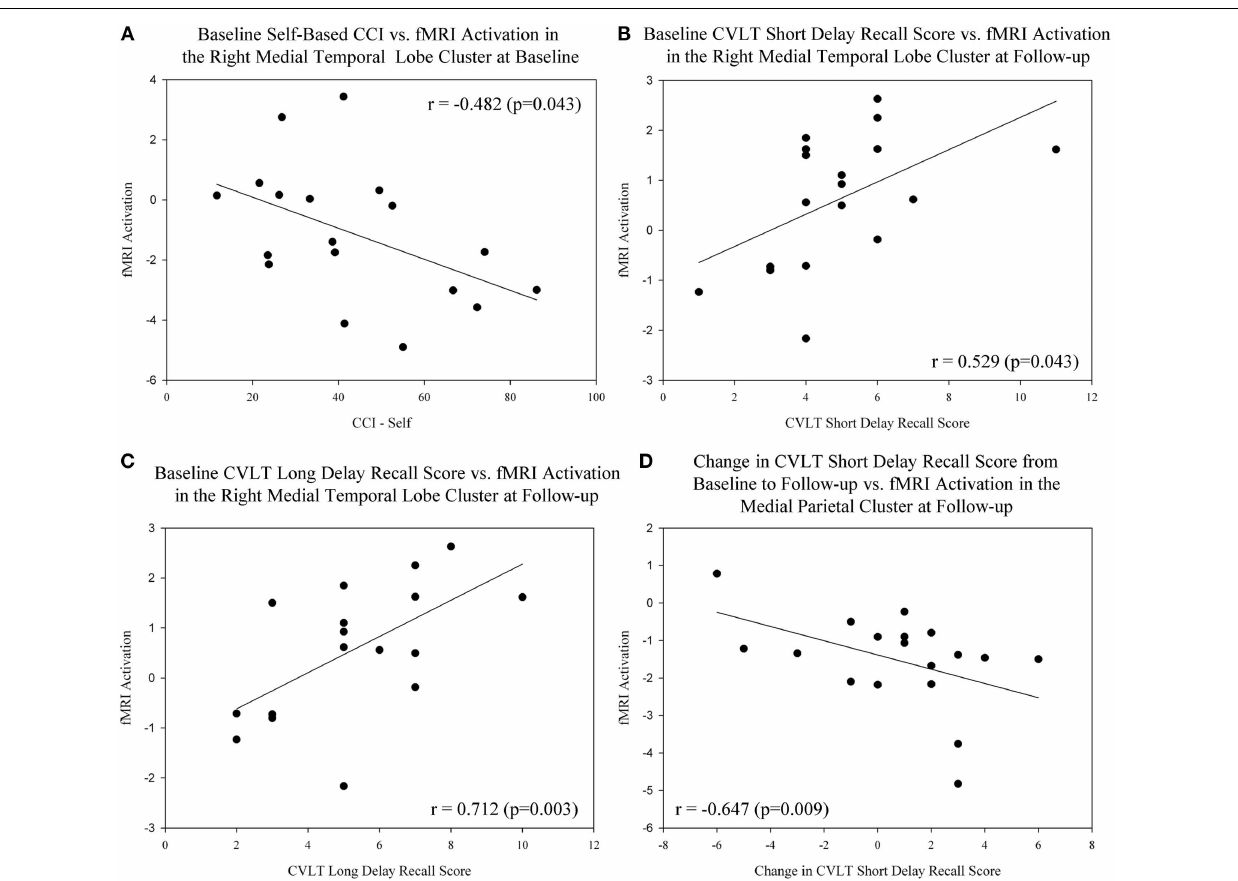
deactivation in the medial parietal cluster at the post-drug follow-up scan ( r =− 0.647, p = 0.009). Note that all medial temporal lobe values are extracted from NEWgtOLD contrasts and all medial parietal lobe values are extracted from NEWgtREST contrasts. Data are displayed as raw values; however, all statistical results include age, gender, and education as covariates. For additional information, see the Sections “Materials and Methods” and “Results” of the manuscript. NEWgtOLD = new items contrasted with old items (encoding > recognition), NEWgtREST = new items contrasted with rest items (encoding > rest), ROI = region of interest, MCI = mild cognitive impairment, HC = healthy older adults, CVLT = CaliforniaVerbal LearningTest, CCI = cognitive complaint